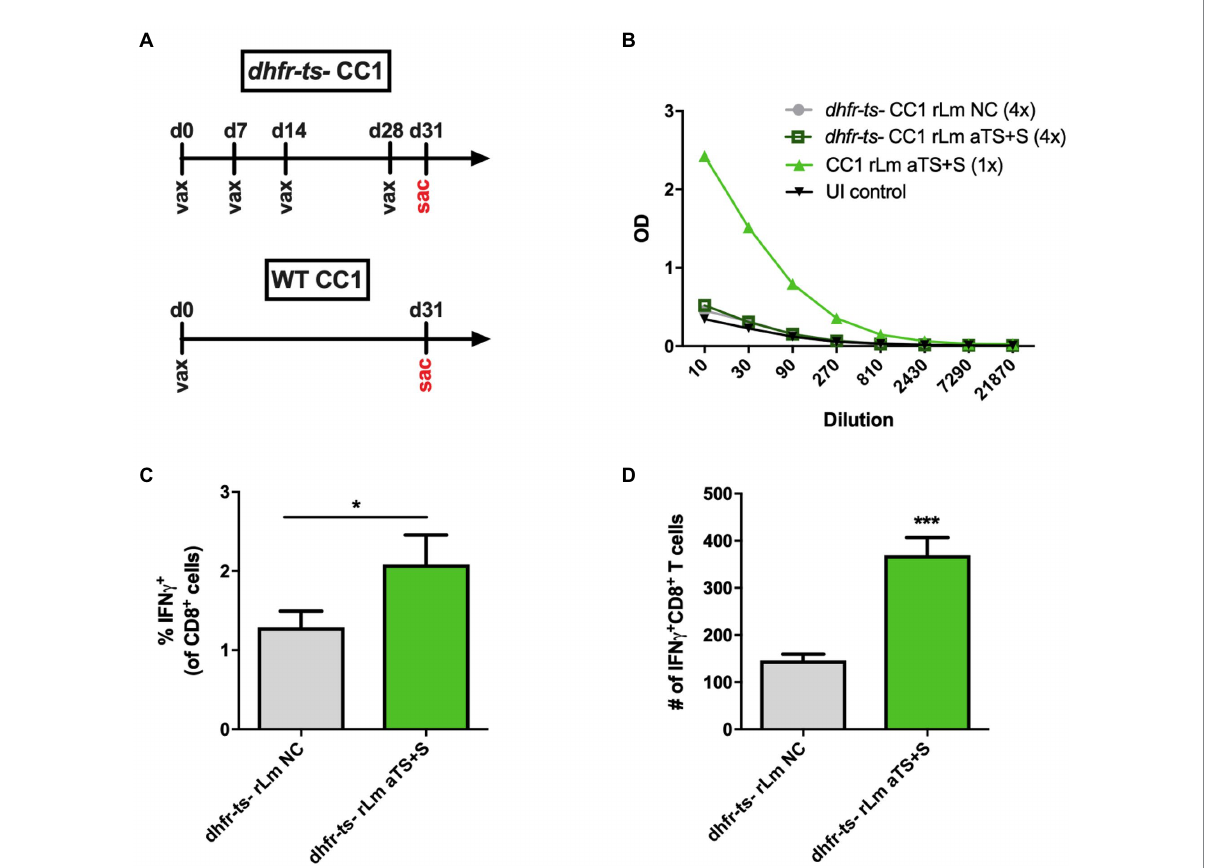
FIGURE 5 Recombinant TS-expressing dhfr-ts − - CC1 L. major parasites are less immunogenic compared to virulent recombinants. (A) Mice were inoculated four times with 10 6 attenuated dhfr-ts − CC1 L. major parasites transfected with a control vector (NC) or secreted TS (aTS+S). Some mice were inoculated once with 10 6 WT CC1 r Lm aTS+S as a positive control. (B) Mice inoculated with dhfr-ts − r Lm expressing aTS+S did not have significantly higher antibody titers compared to mice inoculated with control dhfr-ts − r Lm parasites. However, on ICS assay, greater percentages (C) and numbers (D) of spleen cells recovered from mice vaccinated with dhfr-ts − r Lm aTS+S expressed IFN- γ in response to re-stimulation, compared to mice vaccinated with control